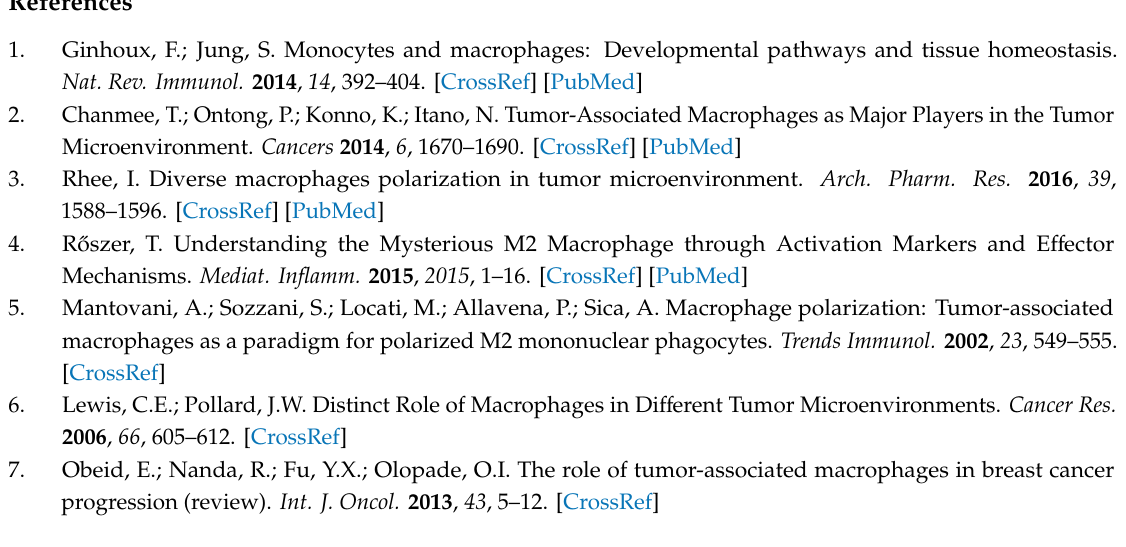
and corresponding β -actin, repetition 2, Figure S14. Uncropped Western Blot images: CYP24A1 and corresponding β -actin, repetition 3, Figure S15. Uncropped Western Blot images: CYP24A1 and corresponding β -actin, repetition 4, Table S1. Production of cytokines and chemokines of cell culture supernatants by BMDMs polarized in the presence or absence of